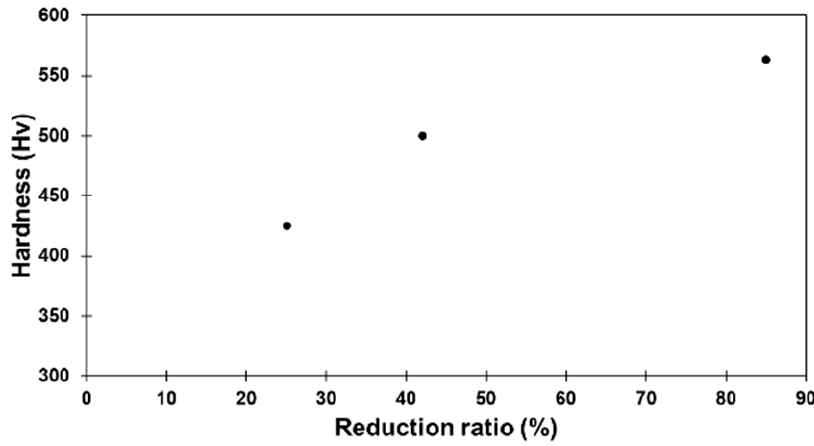
Figure 3. Evolution of mean hardness with rolling reduction before annealing. Error bar is smaller or about marker size.